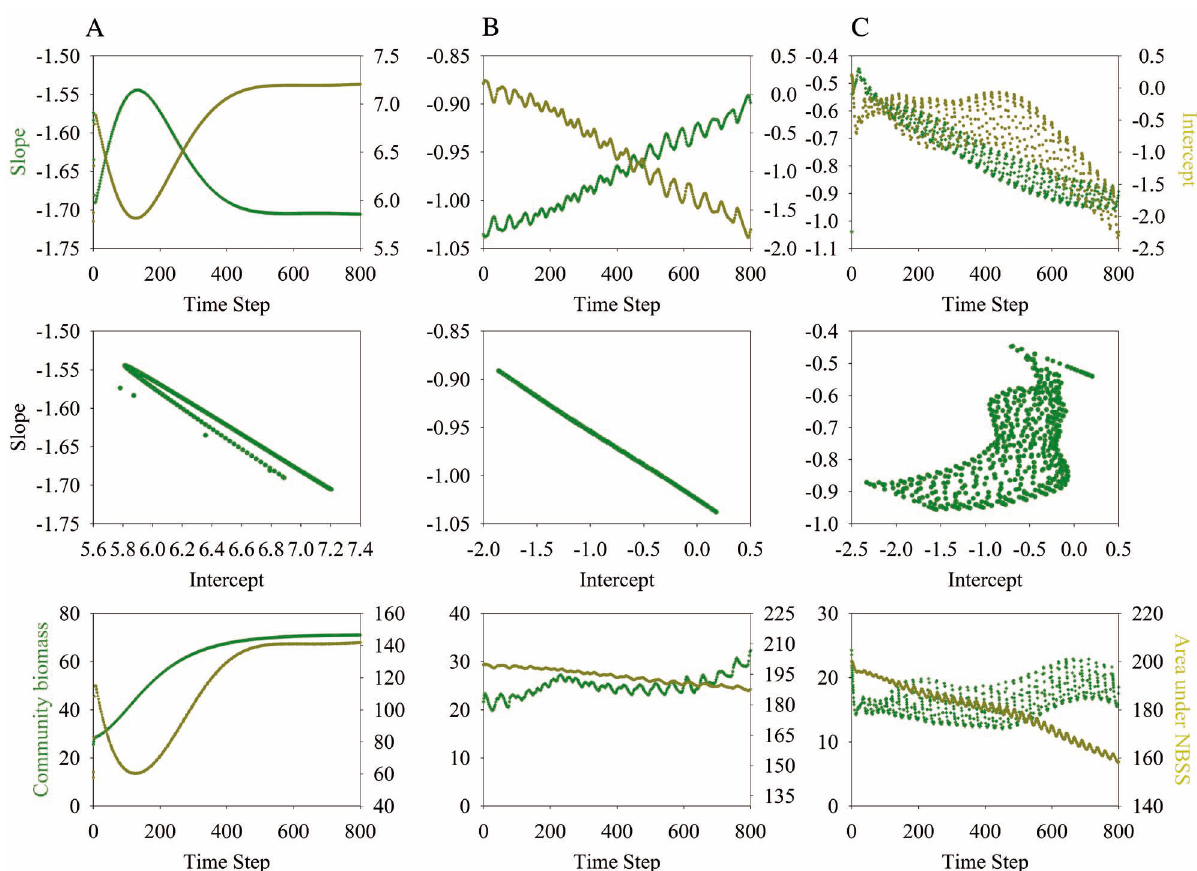
F ig . 6. – Examples of the behaviour of the coefficients b (green line) and a (yellow line) of normalized biomass-size spectra (upper panels), the relationship between the same two coefficients (medium panels), and comparison between the two approaches used to measure the total community biomass (lower panels), summing the biomass of all the species (green line), and calculating the surface area under the normalized biomass size spectra (yellow line). Panels A and B represent regular biomass pyramids, and panel C an inverted biomass